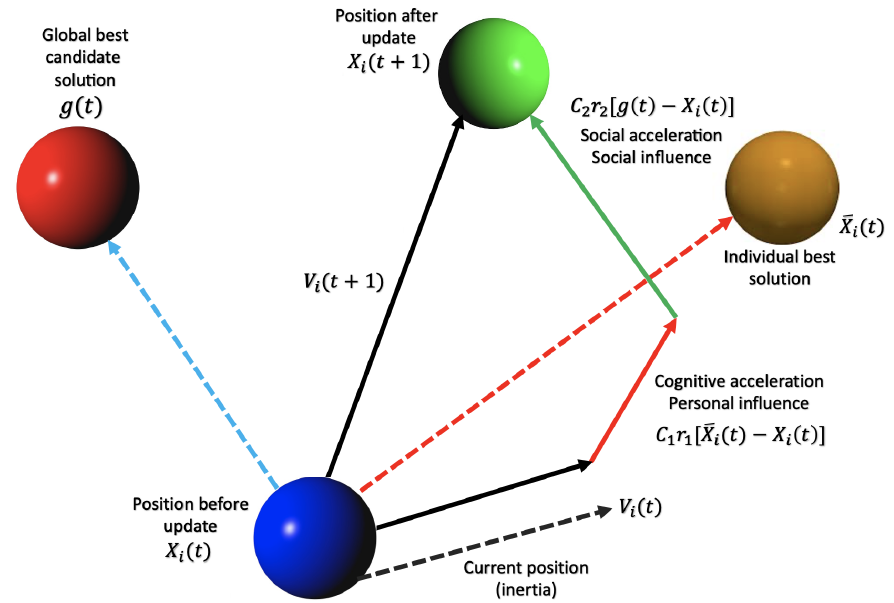
Figure 5. Particle swarm